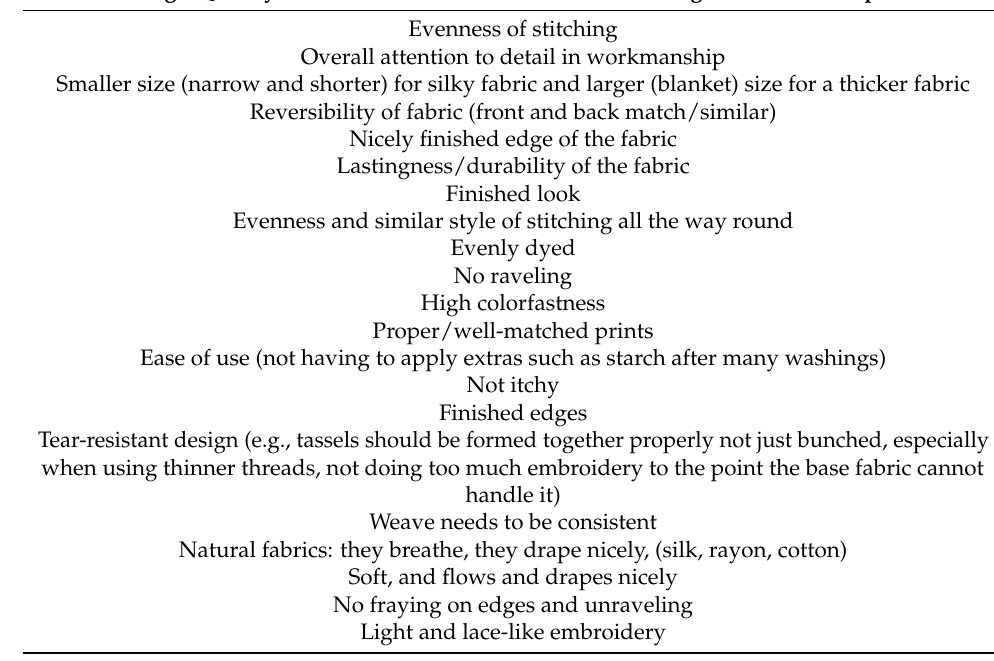
Table 2. List of 46 high-quality terms/statements for textiles that were generated from the fo- cus